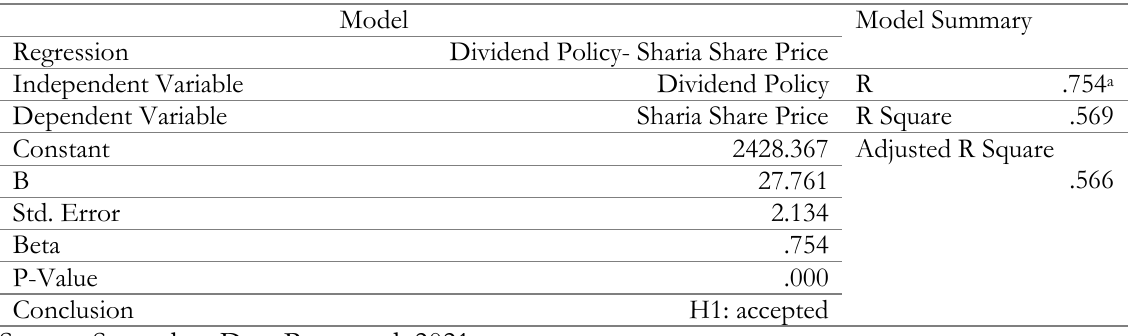
Table 1 Regression